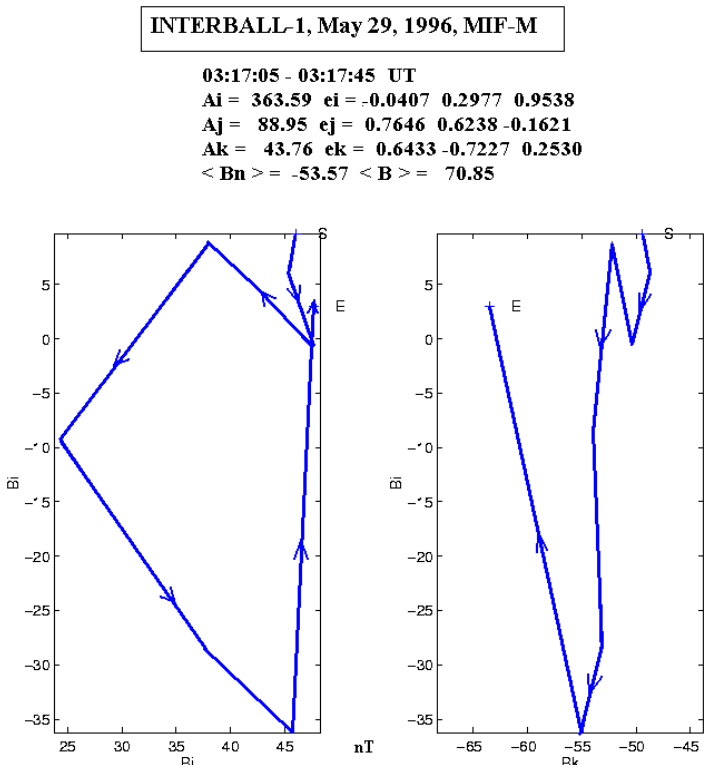
Fig. 4a. Magnetic field hodogram of the Interball vortex-like structure in the main MP current sheet on 29 May 1996. The vortex scale in the minimum variance direction is estimated by ∼ 1000km (see text for details). The maximum, medium and minimum variance eigen values and eigen vectors are given at the top of the figure in the GSM coordinate system along with the average normal component h Bn i and the magnetic field magnitude h B i